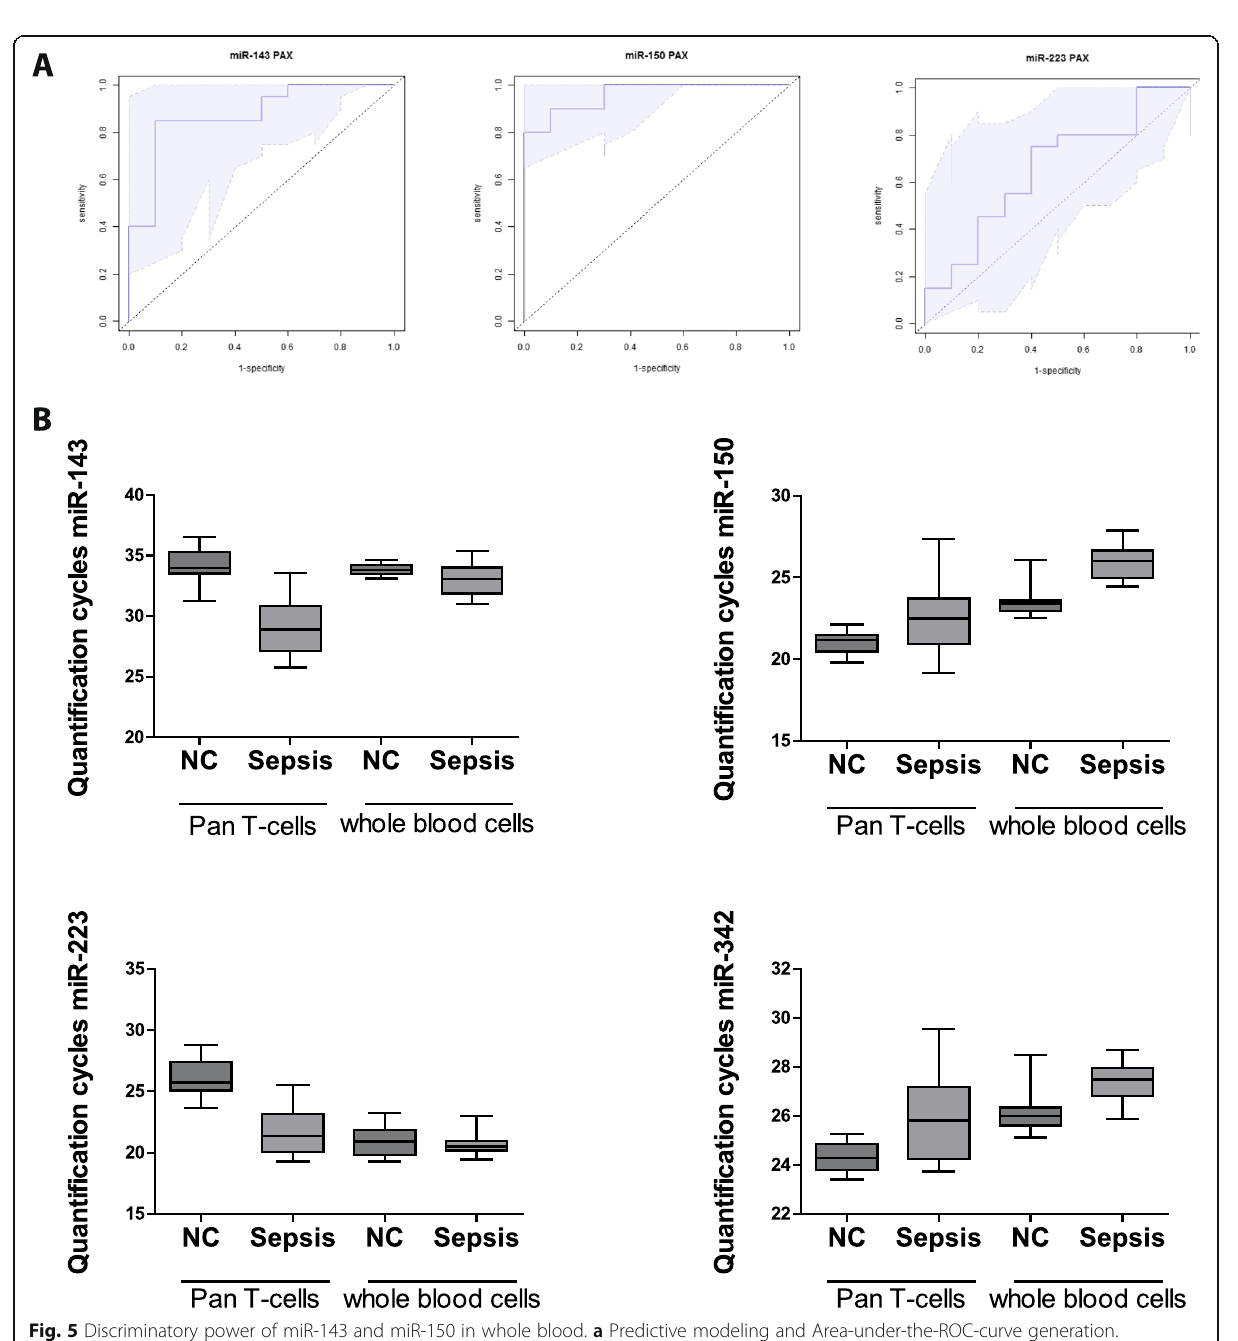
Fig. 5 Discriminatory power of miR-143 and miR-150 in whole blood. a Predictive modeling and Area-under-the-ROC-curve generation. Candidate miRNAs were selected for predictive modeling: miR-143, miR-150 and miR-223 in whole blood samples of septic patients compared to healthy controls, n = 10/20 (NC/Sepsis). The shadowed areas denote the confidence interval for the area under the curve. b MiRNA quantification cycles of human CD4 + T-cells and whole blood cells. Samples of septic patients and healthy controls were measured, n =10/20 (NC/Sepsis),performed in duplicates. Equal amounts of RNA were used to determine quantification cycles of miR-143, miR-150, miR-223 and miR-342 by TaqMan miRNA assay. Data are shown as median, 25th and 75th percentile and